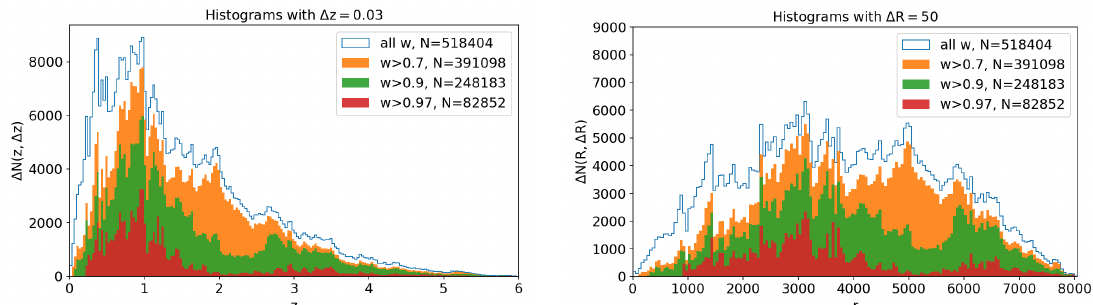
Figure 3. High resolution differential histograms of radial distribution of galaxies from the COSMOS2015 catalogue in redshift space ( left ) with ∆ z = 0.03, and metric space ( right ) with ∆ r ( z ) = 50 Mpc for the various values of the sampling parameter w